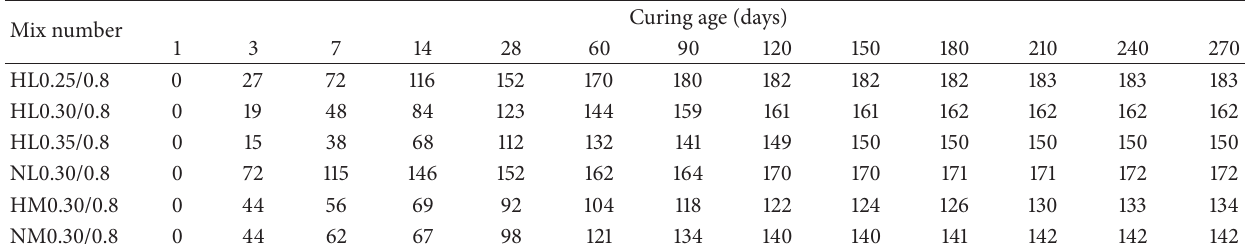
Table 7: Test results of autogenous shrinkage of SFRLAC.